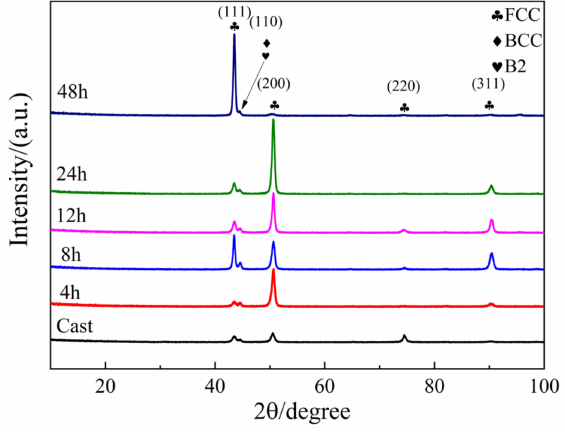
Figure 1. XRD patterns of Al 0.6 CrFe 2 Ni 2 HEAs at as-cast and cryogenically treated